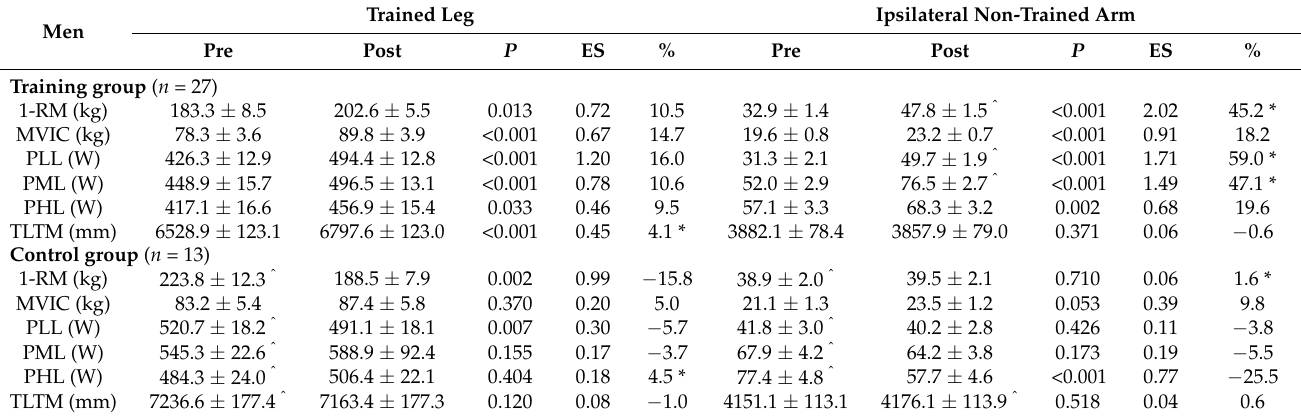
Table 1. Changes (mean ± SD) in unilateral one-repetition maximal strength (1-RM), unilateral maximal voluntary isometric contraction (MVIC), concentric mean power at low (PLL, 40% of 1-RM), medium (PML, 60% of 1-RM), and high loads (PHL, 80% of 1-RM), and total lean tissue mass (TLTM), for the trained leg (TL) and non-trained arm (NTA) for the training group and control group before (Pre) and after training (Post) in men. The p -value for the comparison between pre- and post-training values by Bonferroni test, and effect size (ES) for the changes, the magnitude of change (%) are shown for each